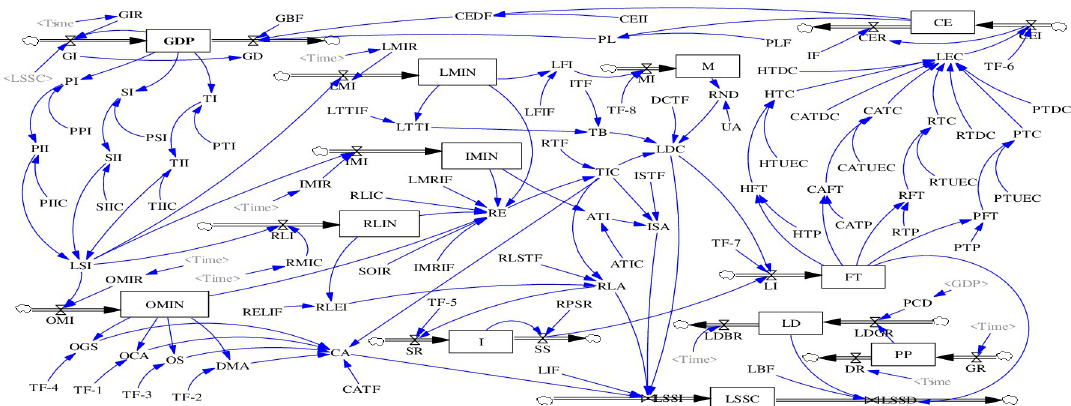
Fig 3. Stock and flow diagram. Source: Authors’ own work.